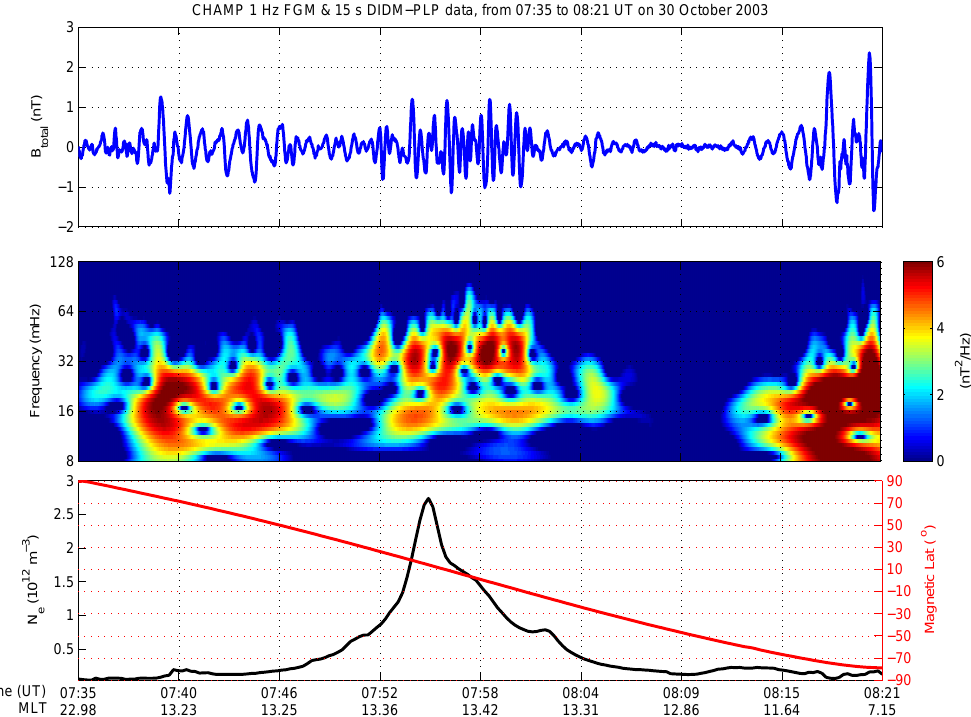
Fig. 3. The CHAMP track from 07:35 to 08:21UT on 30 October 2003. From top to bottom are shown the time series of the CHAMP total magnetic field, calculated from the 1Hz FGM data after applying a 16mHz high-pass filter, its corresponding wavelet power spectrum as well as the temporal variation of the CHAMP electron density data along with its magnetic latitudinal dependence, indicating that the satellite was moving from the North to the South Pole. The corresponding MLT values are also given at the bottom of the graph. A prominent Pc3 ULF wave is observed starting at around 07:52UT and lasting ∼ 15min. The strong ionospheric currents’ signatures near the poles that cover lower frequencies can also be seen in this